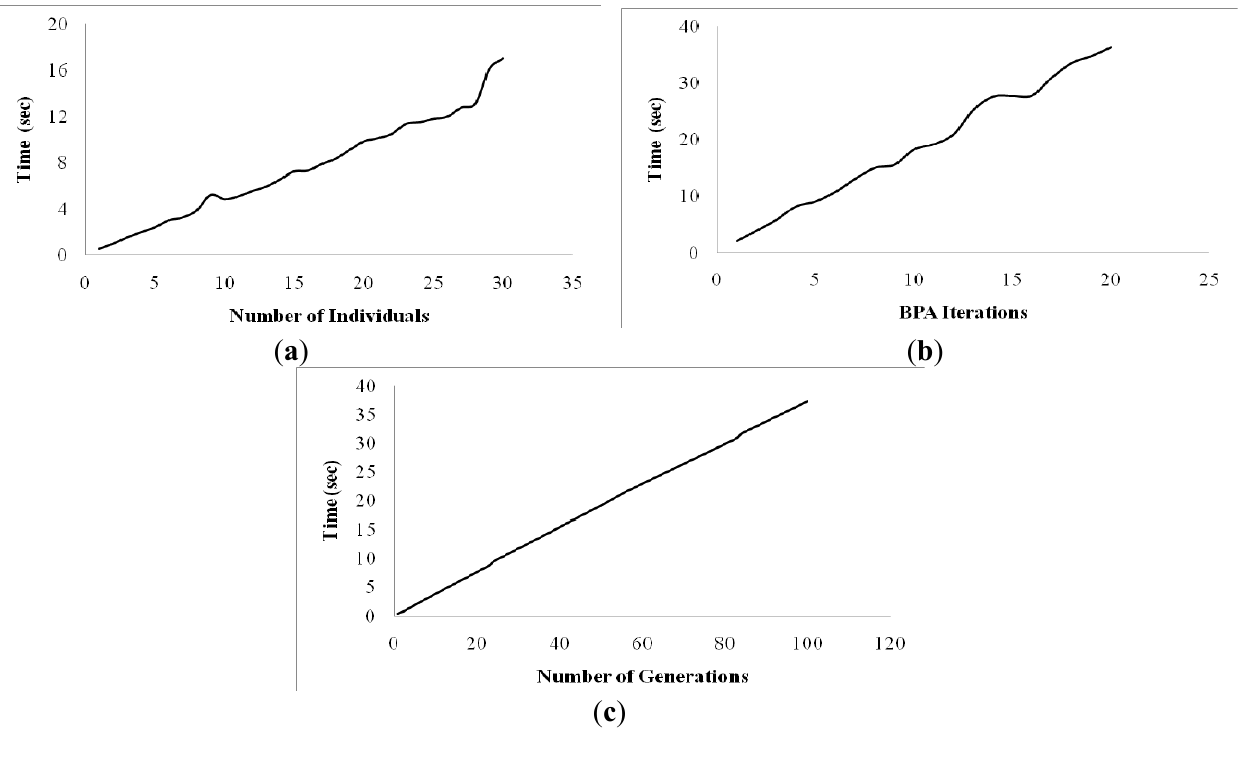
Figure 8. ( a ) Time vs. Number of individuals. ( b ) Time vs. BPA Iterations. ( c ) Time vs. Number of